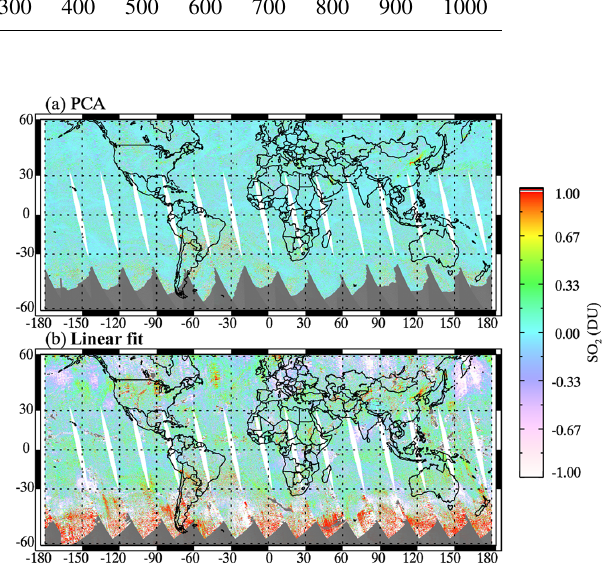
Figure 3. (a) Level 2 OMI SO 2 total vertical column density for 5 August 2006, retrieved with the OMSO2VOLCANO (PCA) al- gorithm assuming a lower tropospheric SO 2 plume with center of mass at 3km altitude (TRL profile). (b) Same as (a) but for the cur- rent operational linear fit algorithm. Only pixels within the center 56 rows are plotted for both